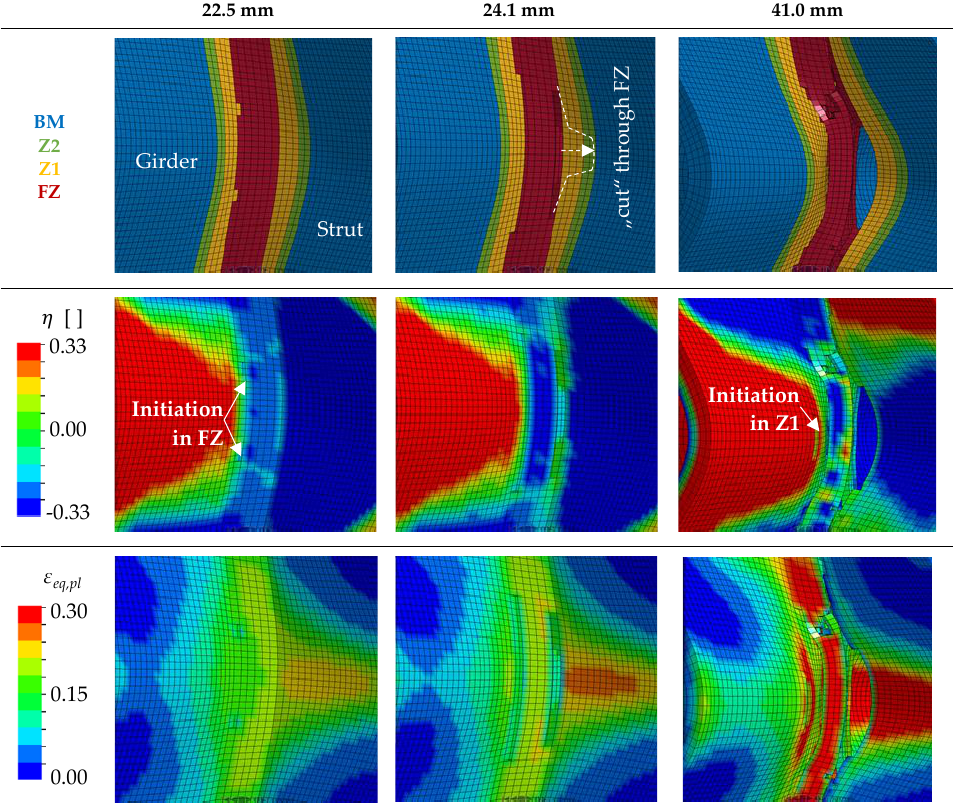
Table 3. Crack initiation and growth in the weld area simulated with the calibrated BW criterion.